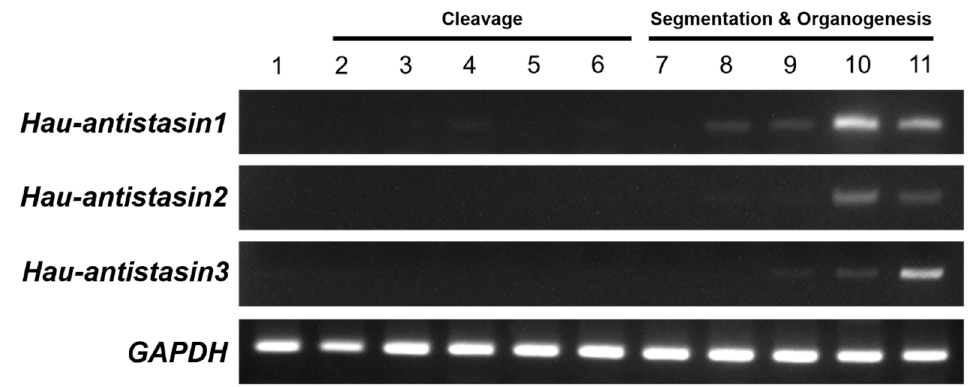
Figure 2. Images of ethidium bromide-stained agarose gels showing replicated developmental semi- 101